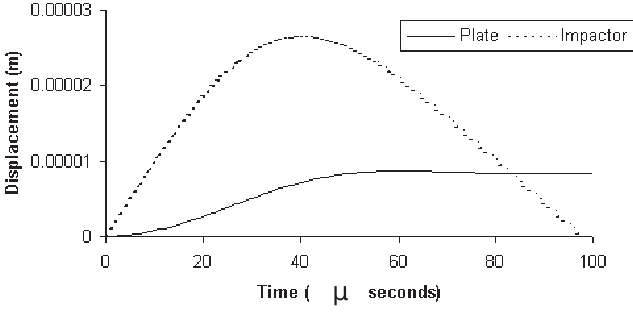
Fig. 4. The impactor displacement and the plate center displacement corresponding to Mesh